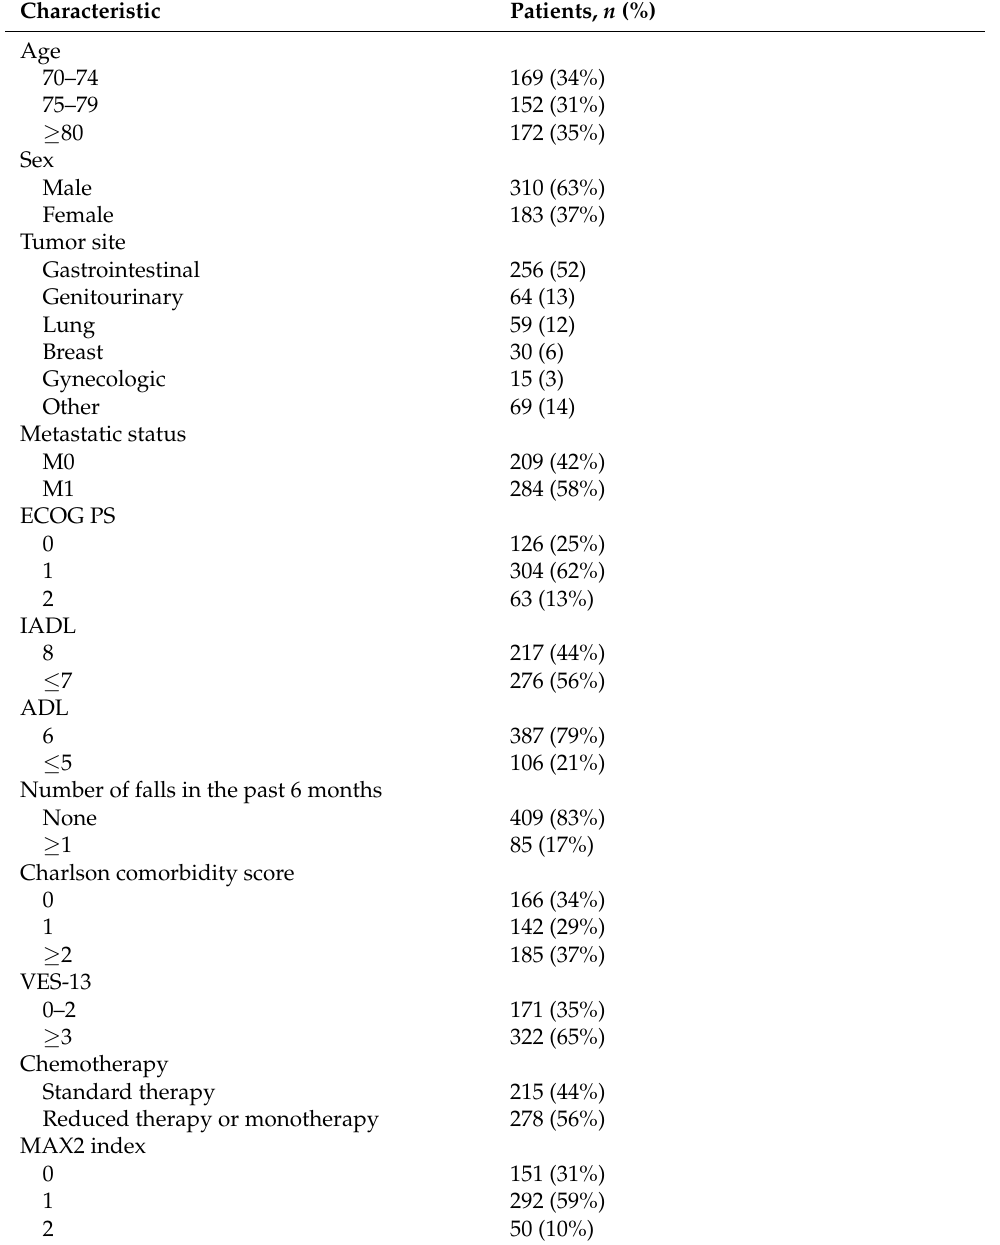
Table 1. Patient characteristics ( n =